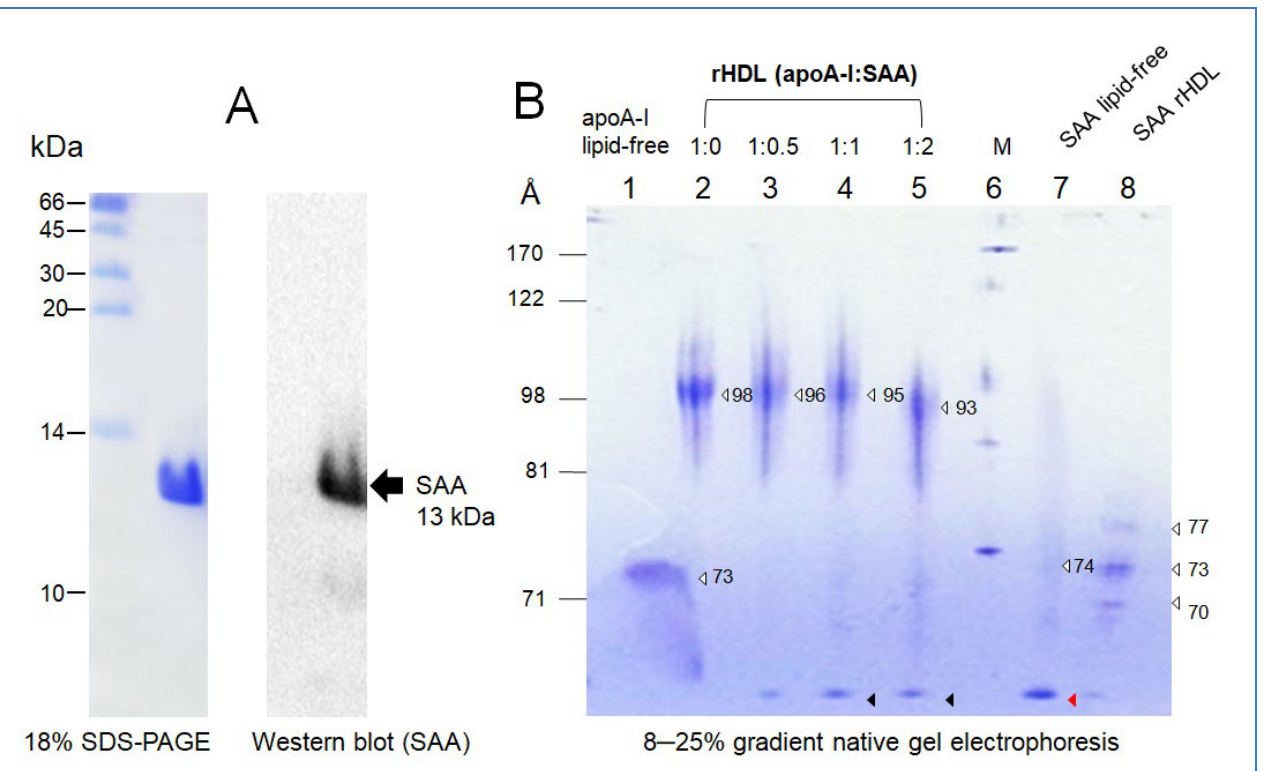
Figure 1. Electrophoretic patterns of purified serum amyloid A (SAA), immunodetection, and reconstituted HDL containing apoA-I and SAA. ( A ) SDS-PAGE analysis and immunodetection with anti-SAA polyclonal antibody (SC20651, Santa Cruz Biotech, CA). ( B ) Non-denaturing 8–25% gradient gel electrophoresis of apoA-I and SAA in the lipid-free and lipid-bound state. The white arrowhead symbol indicates major band of each lane. Black arrowhead indicates displaced band from each rHDL. Red arrowhead indicates aggregated band of SAA.